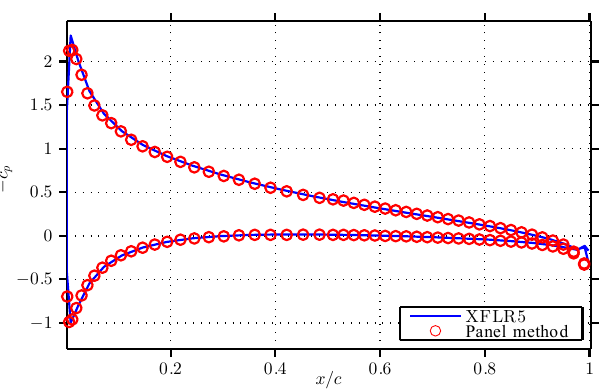
Figure 4. Discretization of the wing surface into panels from Katz and Plotkin (2008).